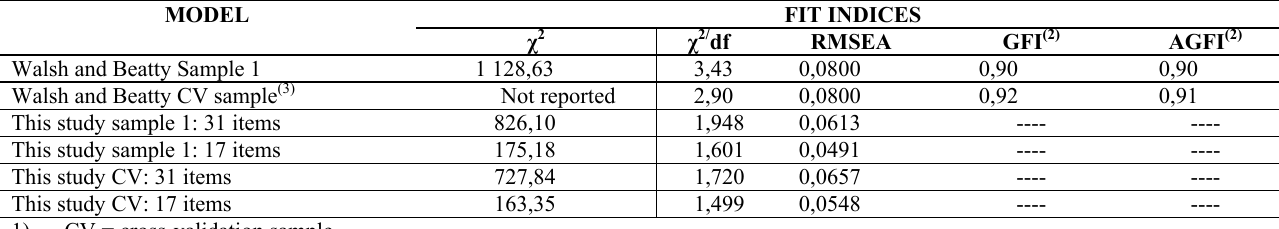
Table 4: Comparison of fit indices (1)